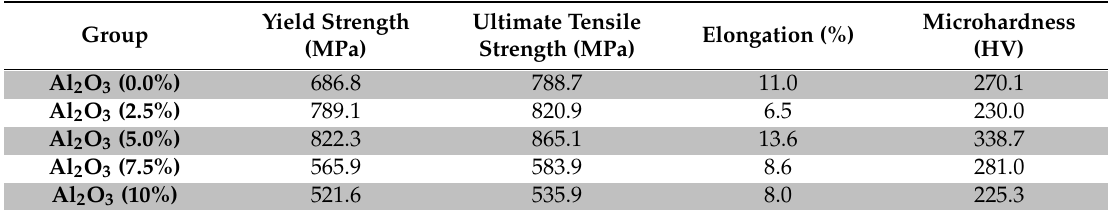
Table 1. Mechanical properties of each group of test pieces.